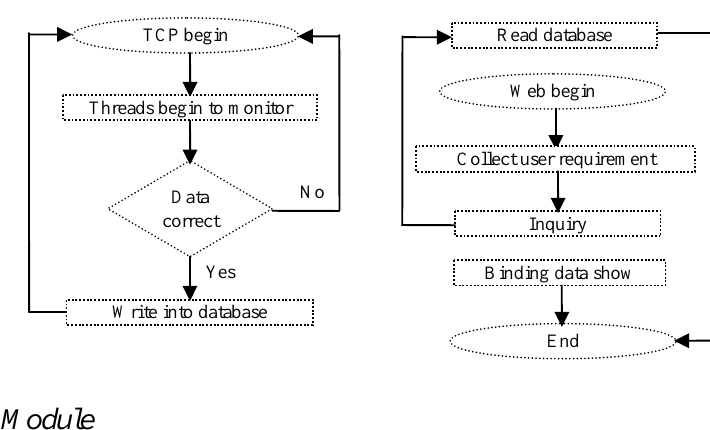
Figure 7. Flow chart of the data releasing